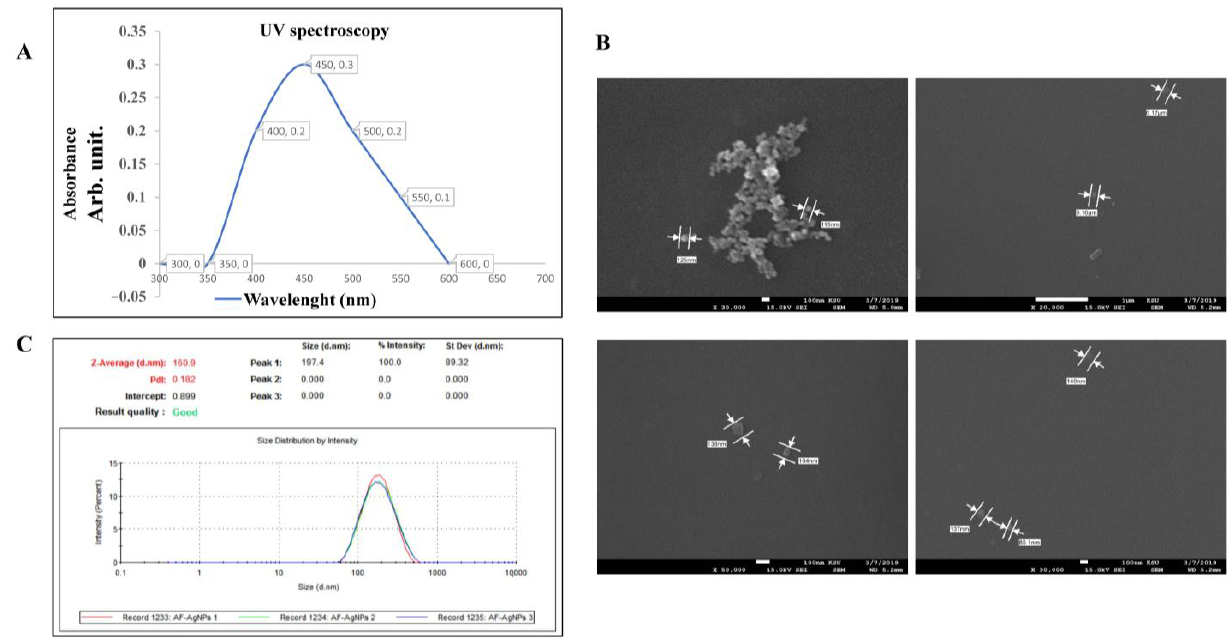
Figure 2. The biogenic properties of AF-AgNPs. The physical properties of the biosynthesized nanoparticles were assessed by UV-2450 Shimadzu spectrophotometer- Energy-dispersive X-ray spectroscopy (EDX) analysis and SEM. ( A ) UV visible spectra of Ag nanoparticles, ( B ) SEM results at 15 Kv, ( C ) percentage intensity of particle size distribution of biosynthesized AF-NPs. UV, ultraviolet; PdI, polydispersity index.